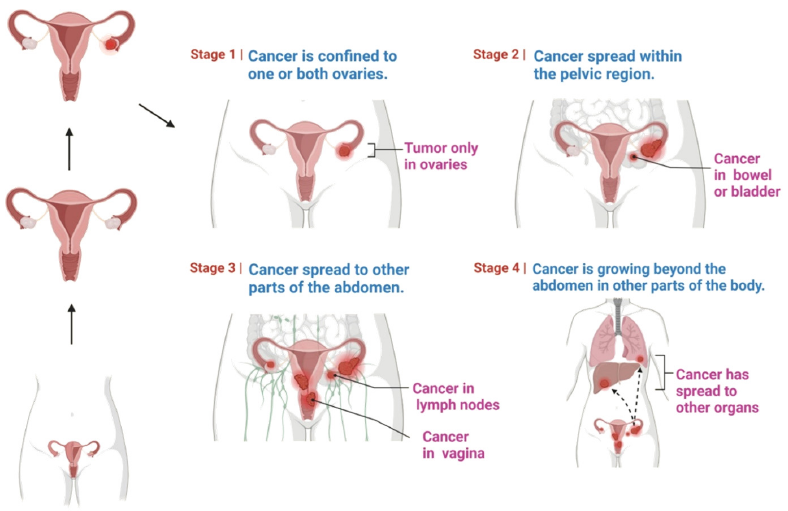
Figure 2. Stages of ovarian cancer, which vary from stage 1 to stage 4.